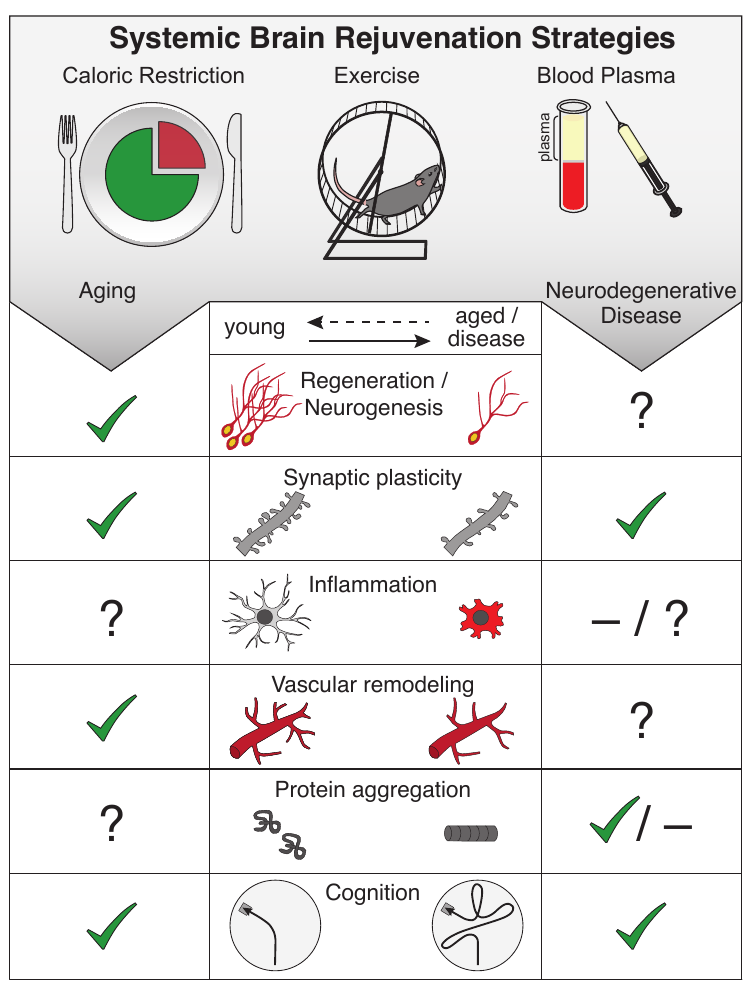
Figure 1. Systemic brain rejuvenation strategies. Hallmarks of brain aging amenable to rejuvenation (middle panel) include decreased regenerative capacity (neurogenesis), impaired synaptic plasticity, increased inflammation, vascular remodeling, increased protein aggregation, and impaired cognitive function. Systemic interventions (top panel), such as caloric restriction, exercise, and blood plasma administration, have been shown to rejuvenate hallmarks of brain aging (left panel) and ameliorate exacerbated pathology in models of neurodegenerative disease (right panel). Cellular or functional rejuvenation elicited by systemic interventions is denoted by a check ( ✔ ), lack of rejuvenation is denoted by a dash ( – ), and yet-to-be-determined effects are denoted by a question mark